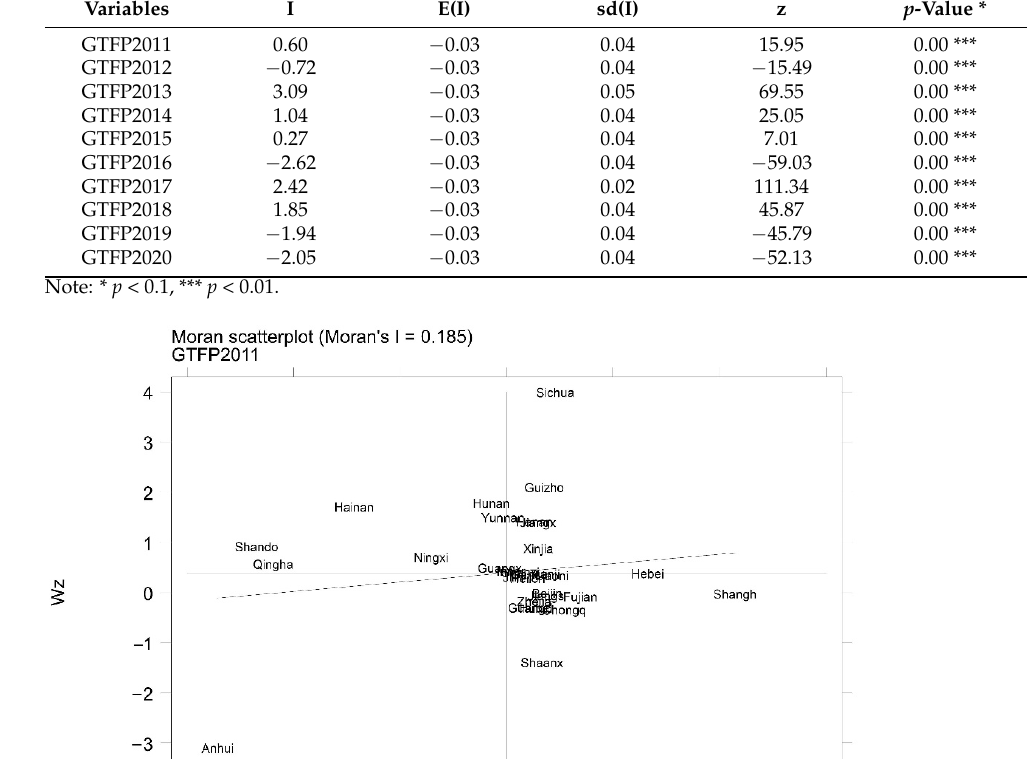
Table 5. Global Moran I test for GTFP in China, 2011–2020. Variables